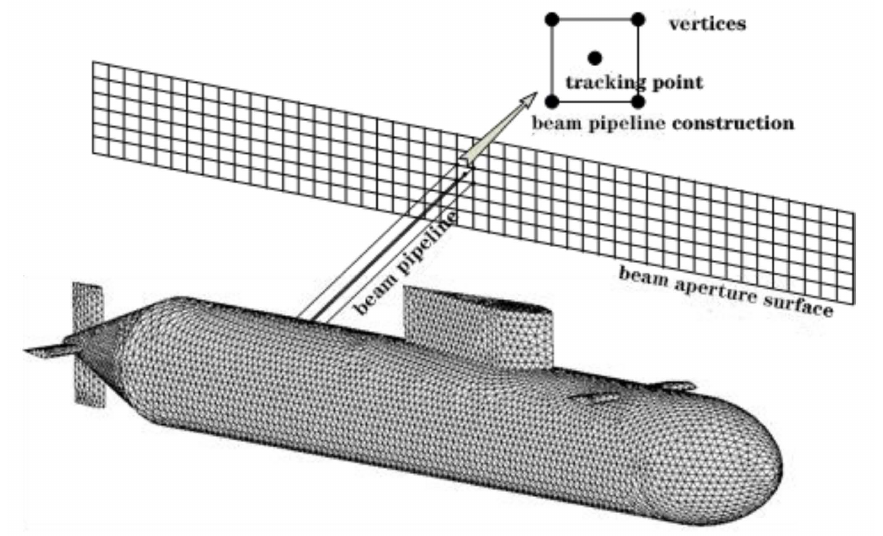
Figure 2. Beam aperture surface and beam pipeline